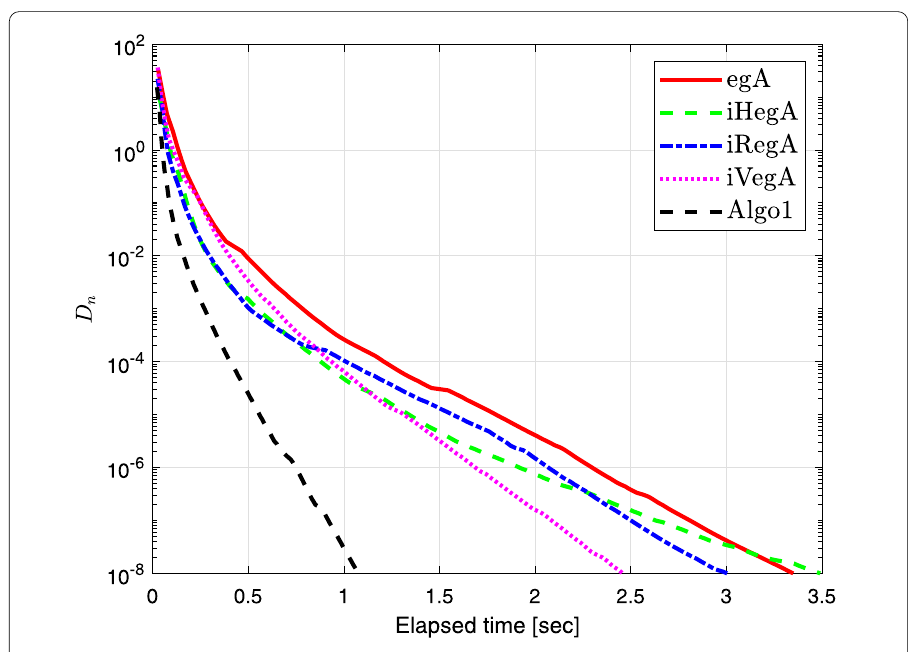
Figure 3 Example 5.1 when n = 200: the number of iterations is 154, 150, 135, 129, 113, respectively